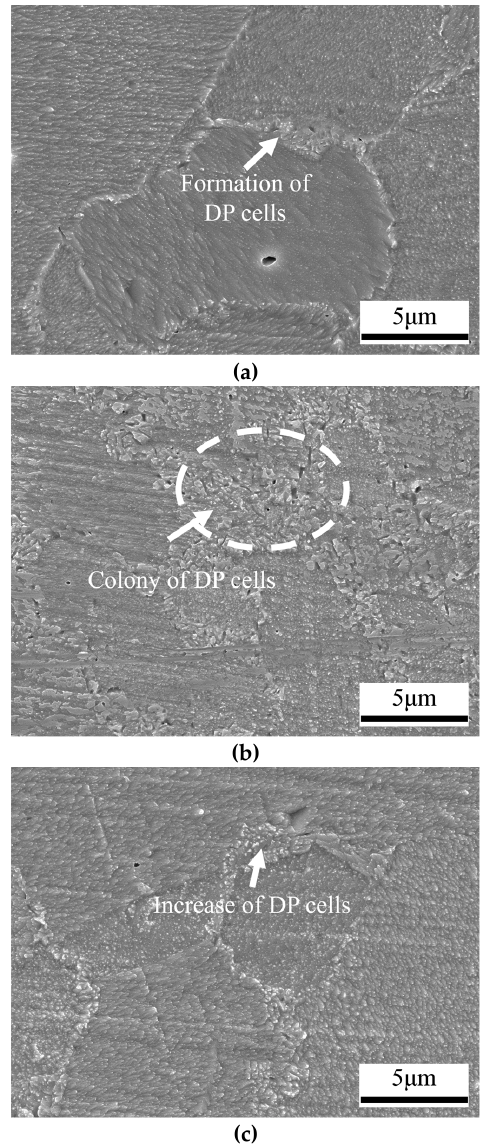
Figure 11. SEM images of discontinuous precipitation (DP) cells formed at the grain boundaries of the stir zone subject to PWHT: ( a ) 0.5 hour, ( b ) three hours and ( c ) eight hours.